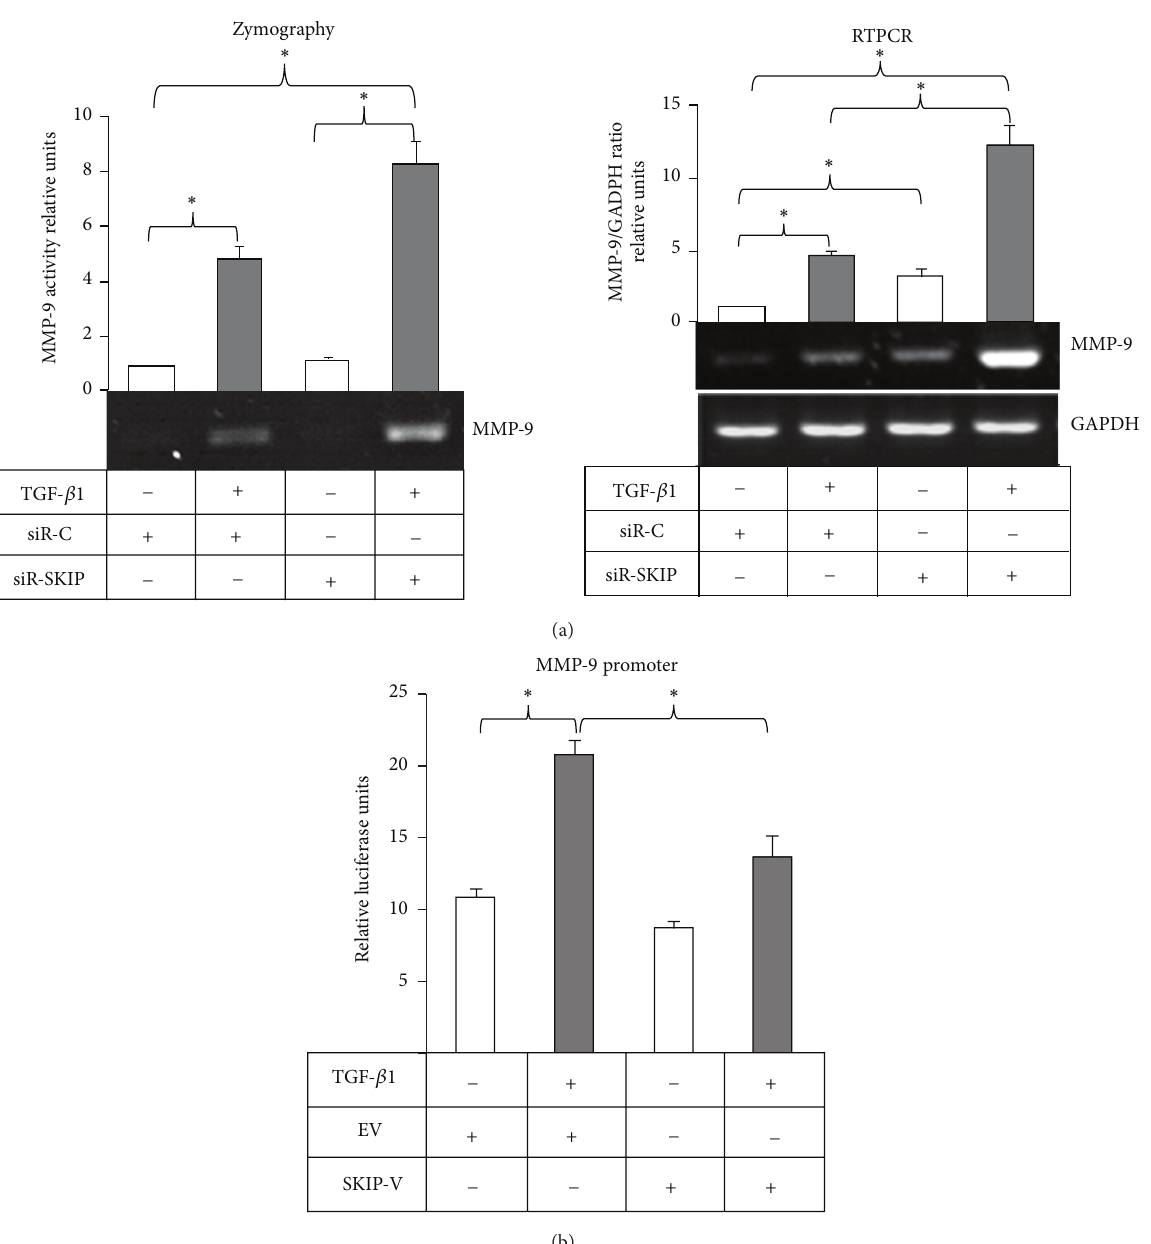
Figure 4: Effect of SKIP knockdown on TGF- 𝛽 1-induced MMP-9 production. (a) MMP-9 zymography assay and RT-PCR analysis in PC-3 cells transfected with either siR-C or siR-SKIP and treated with TGF- 𝛽 1 for 24h. GAPDH was amplified as RT-PCR control for the amount of cDNA present in each sample. (b) Transactivation of MMP-9 promoter in PC-3 cells is transiently transfected with empty vector (EV) or SKIP-Ha tagged expressing vector (SKIP-V). MMP-9 promoter activity was assayed in cells unstimulated and stimulated with TGF- 𝛽 1 for 48h. 𝛽 -Galactosidase was used as an internal control of